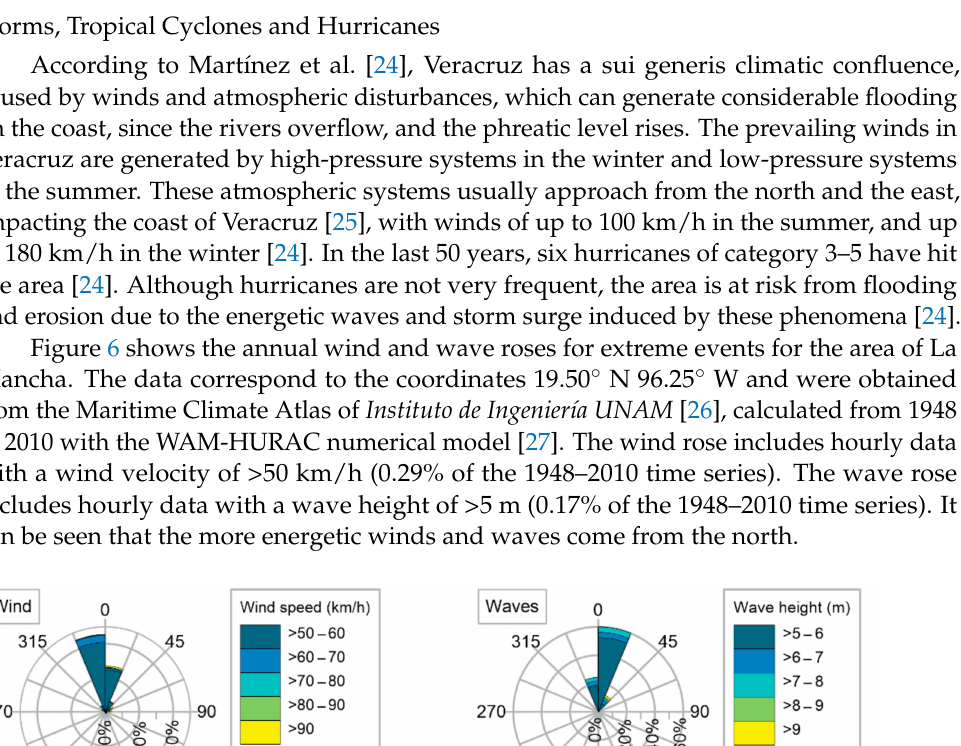
20 ◦ 57 (cid:48) 12 (cid:48)(cid:48) N) [28], and Veracruz (96 ◦ 07 (cid:48) 51 (cid:48)(cid:48) W 19 ◦ 12 (cid:48) 03 (cid:48)(cid:48) N) [29]. These values are estimated with measured data from July 1999 to December 2017 and are presented in Table 1. The values for La Mancha in Table 1 were calculated with a linear interpolation between the data of Tuxpan and